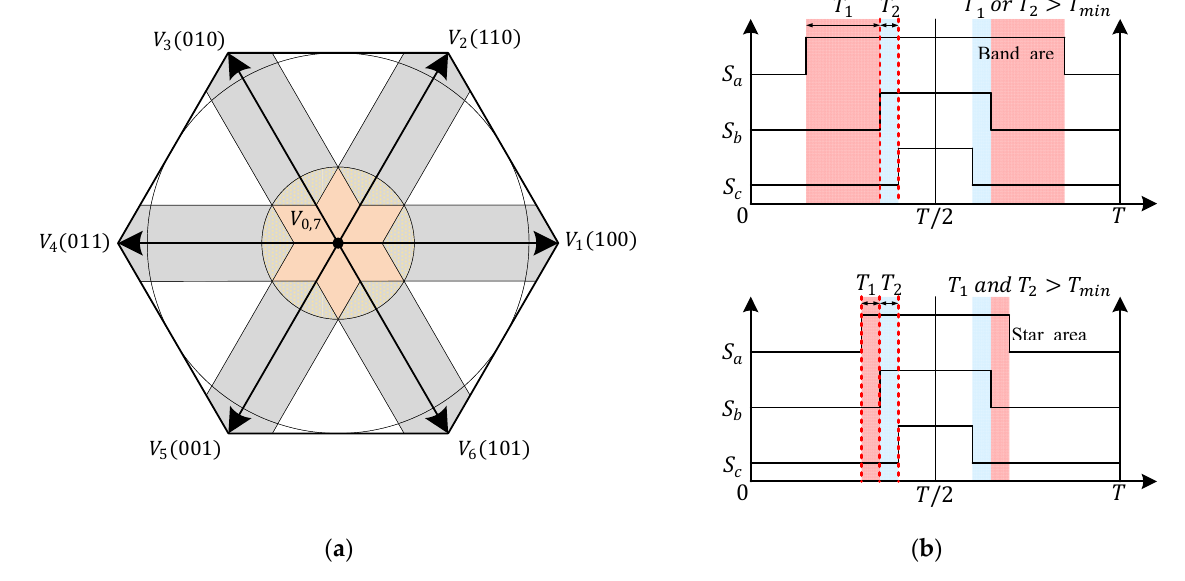
Figure 4. Current undetectable region in single-shunt resistor inverter; ( a ) Current undetectable region in voltage vector; ( b ) PWM in band area and PWM in star area.